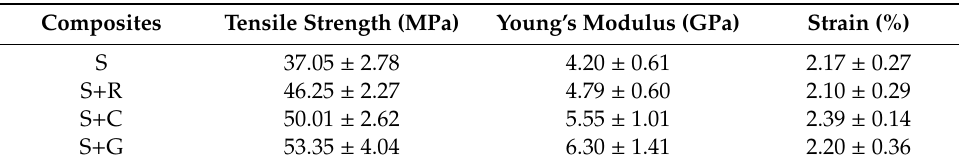
Table 2. Tensile tests data.